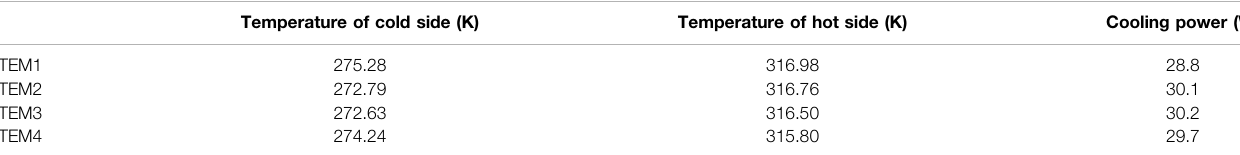
TABLE 3 | The TEM date from Flotherm